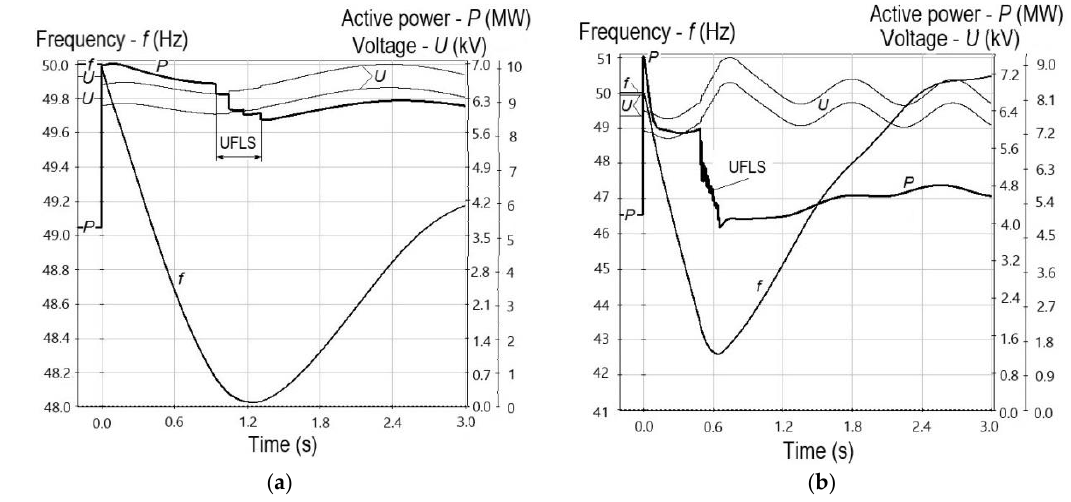
Figure 8. Transient processes: ( a ) A disconnection of one of two STUs P nom = 6 MW; ( b ) A disconnection of three of six GRUs P nom = 2 MW.